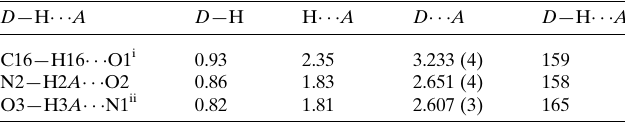
Table 1 Hydrogen-bond geometry (A˚ , (cid:3) ).